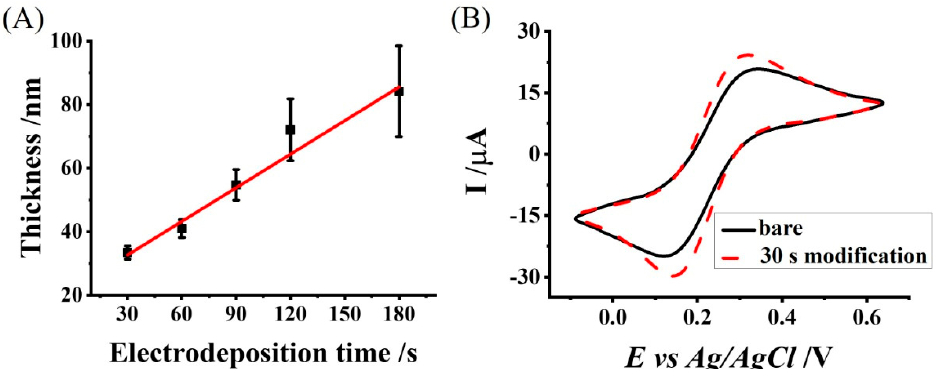
Figure 4. Chitosan-modified electrode characterization. ( A ) The thickness of the chitosan layer for increasing electrodeposition durations; ( B ) Cyclic voltammograms recorded with the bare (solid black) and the chitosan-modified (30 s electrodeposition duration; dashed red) electrodes.